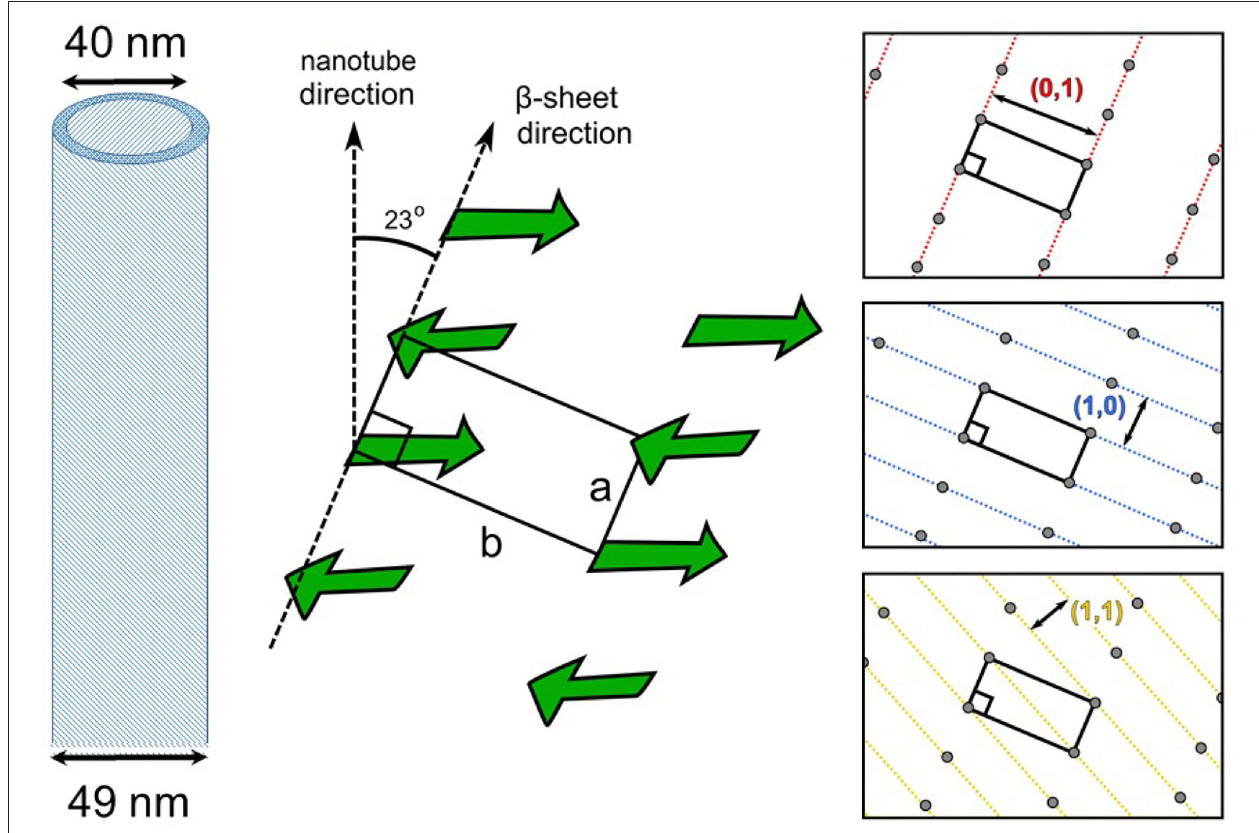
FIGURE 3 | Schematic illustrations of the nanotube, the semi-crystalline architecture within the walls and corresponding orientation of 2D lattice planes of a rectangular unit cell with side lengths a = 0.479 nm and b =